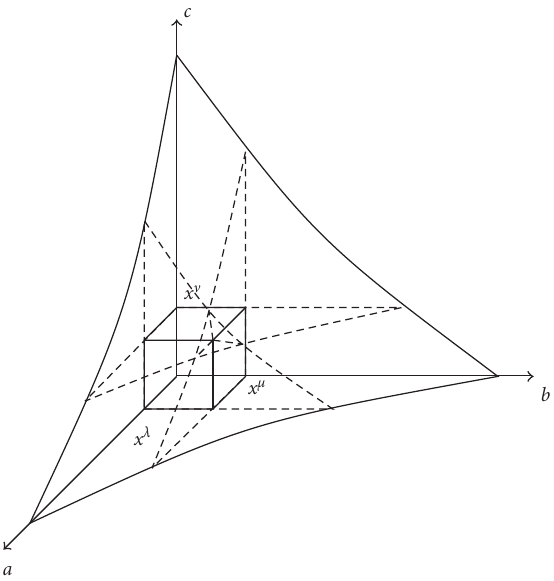
Figure 3: Generalized Dirichlet’s hyperbola method in three dimensional space (proof of Theorem 2